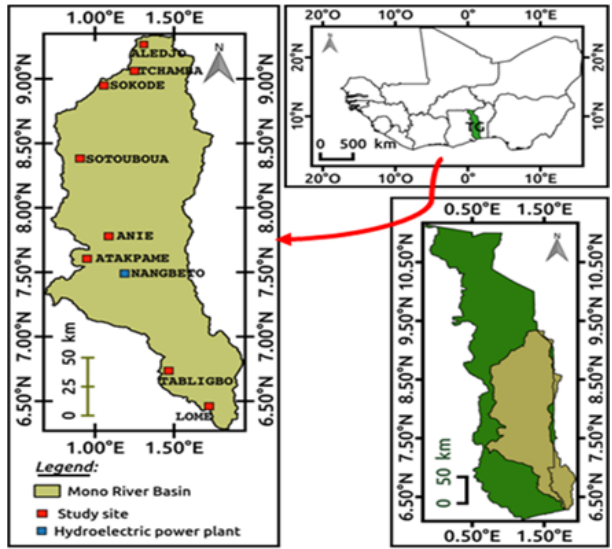
Figure 1. The geographical location (sources Batablinlè et al.,